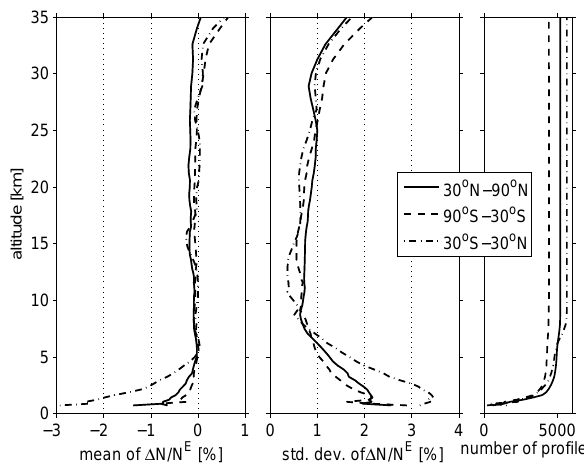
Fig. 13. Same as Fig. 11, but derivative filter parameters reduced from degree three to two and filter order reduced from 101 to 41 (for details see